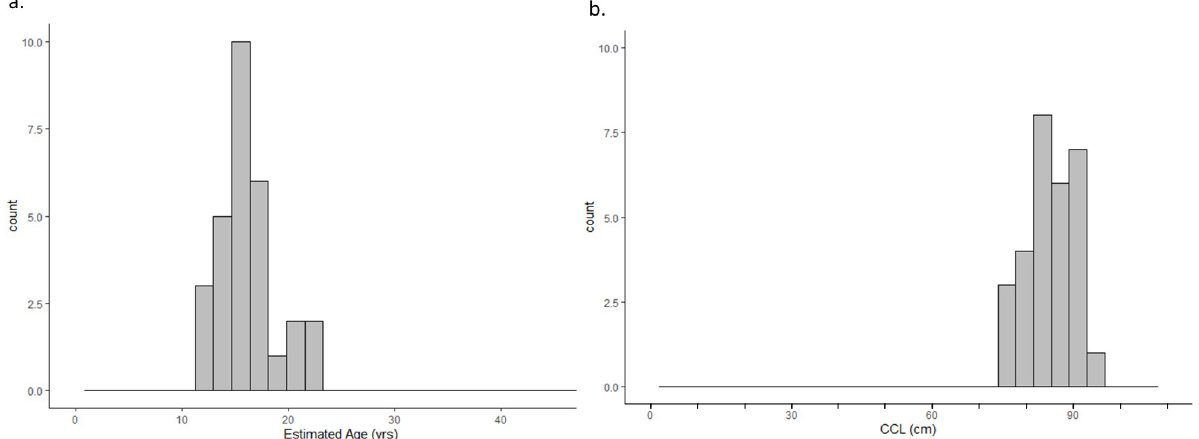
Fig 5. Flatback maturation. Estimated a) age-at-sexual-maturation (ASM) and b) size-at-sexual-maturation (SSM) for n = 29 flatback sea turtles.